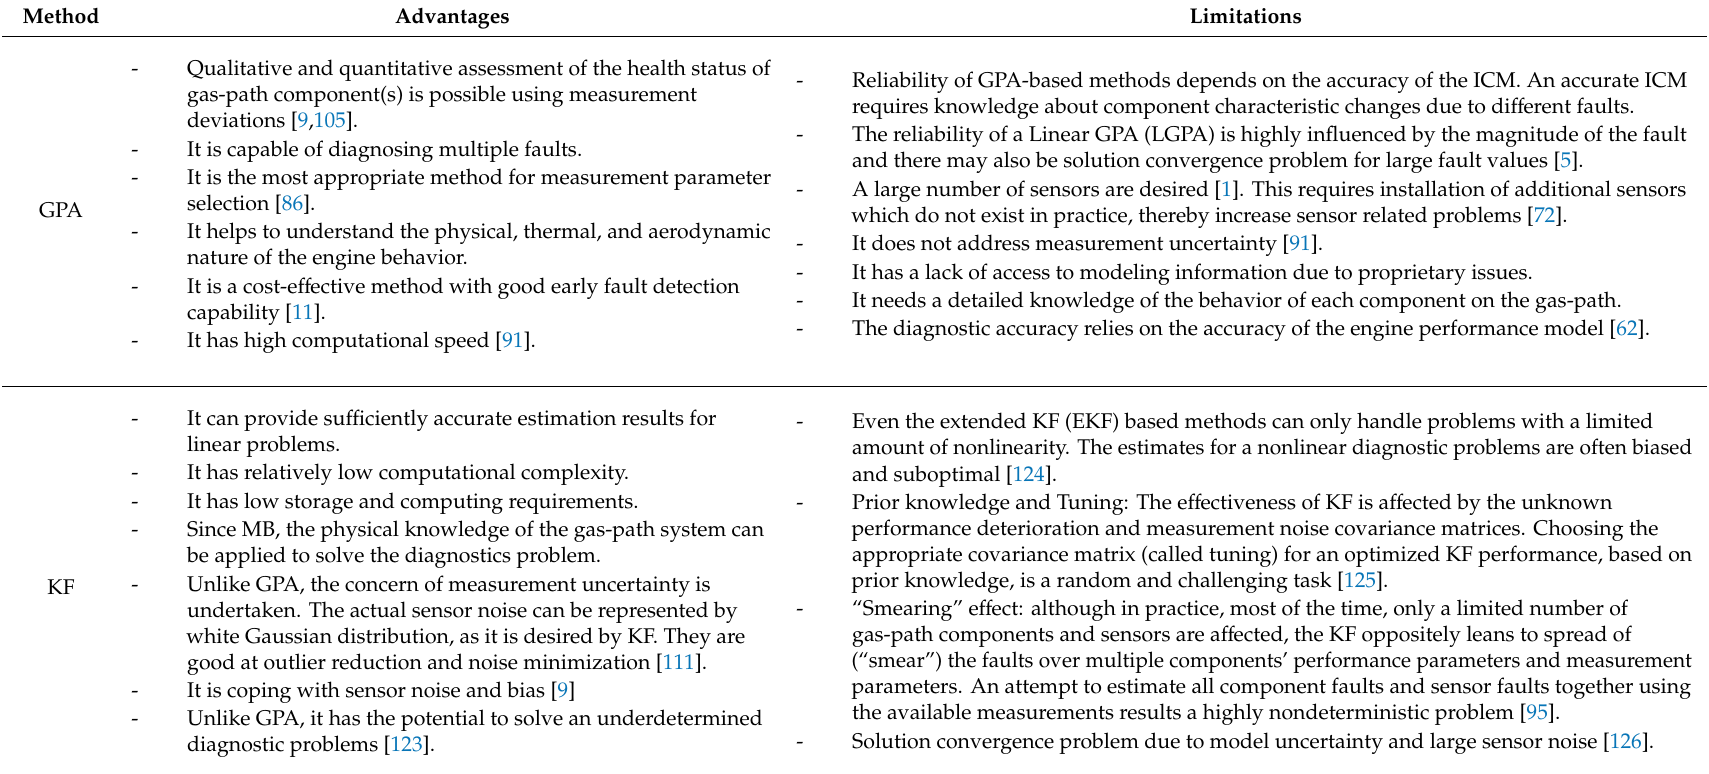
Table 4. Advantages and limitations of GPA and KF related to GT